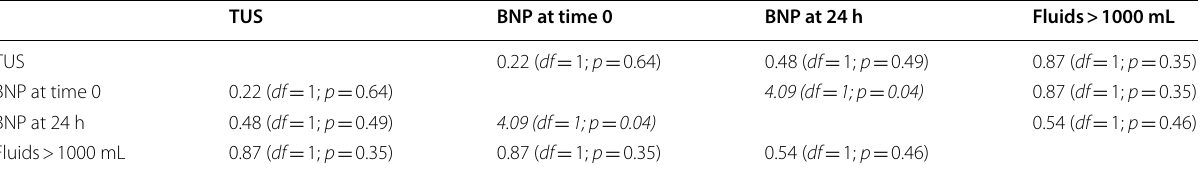
TUS thoracic ultrasound, BNP brain natriuretic